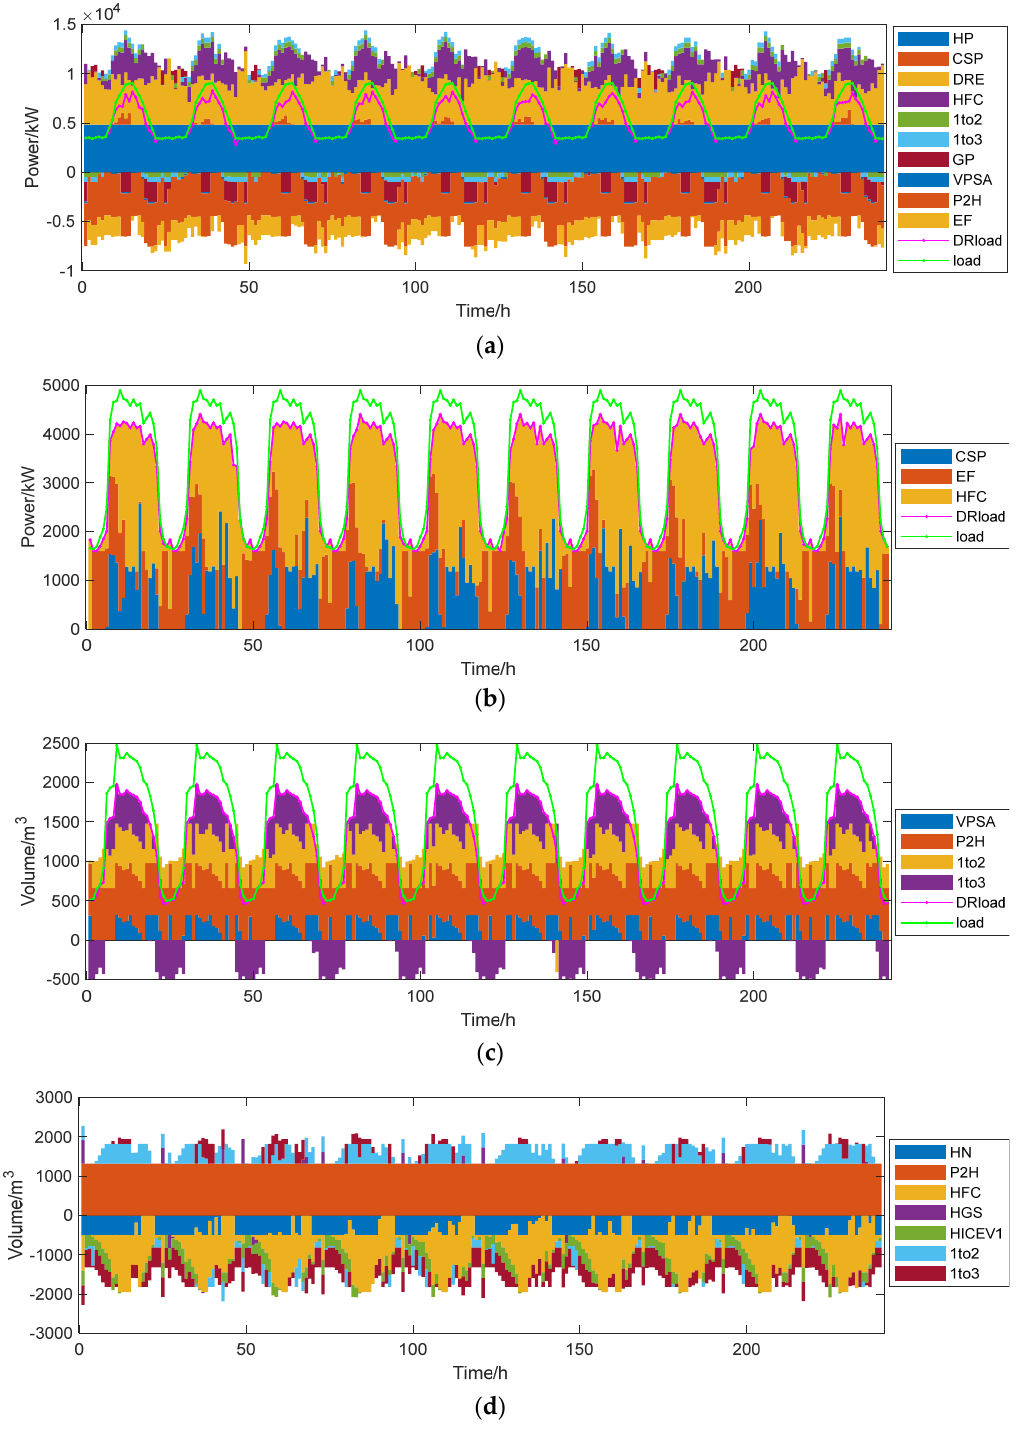
Figure 7. IES1 energy balance. ( a ) IES1 electric power balance. ( b ) IES1 heat power balance. ( c ) IES1 oxygen balance. ( d ) IES1 hydrogen balance.